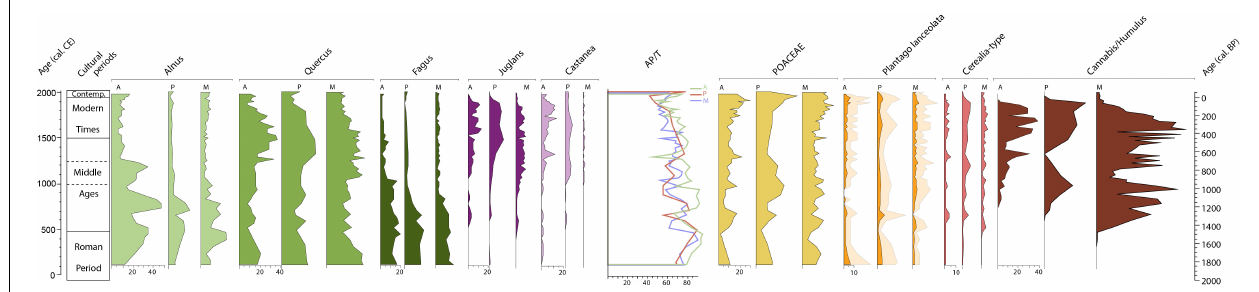
FIGURE 10 | A compilation of key pollen taxa curves from 3 records: Aiguebelette (curve A), Paladru (curve P) and Moras (curve M). ( Plantago lanceolata pollen curve is 4x exaggerated in light